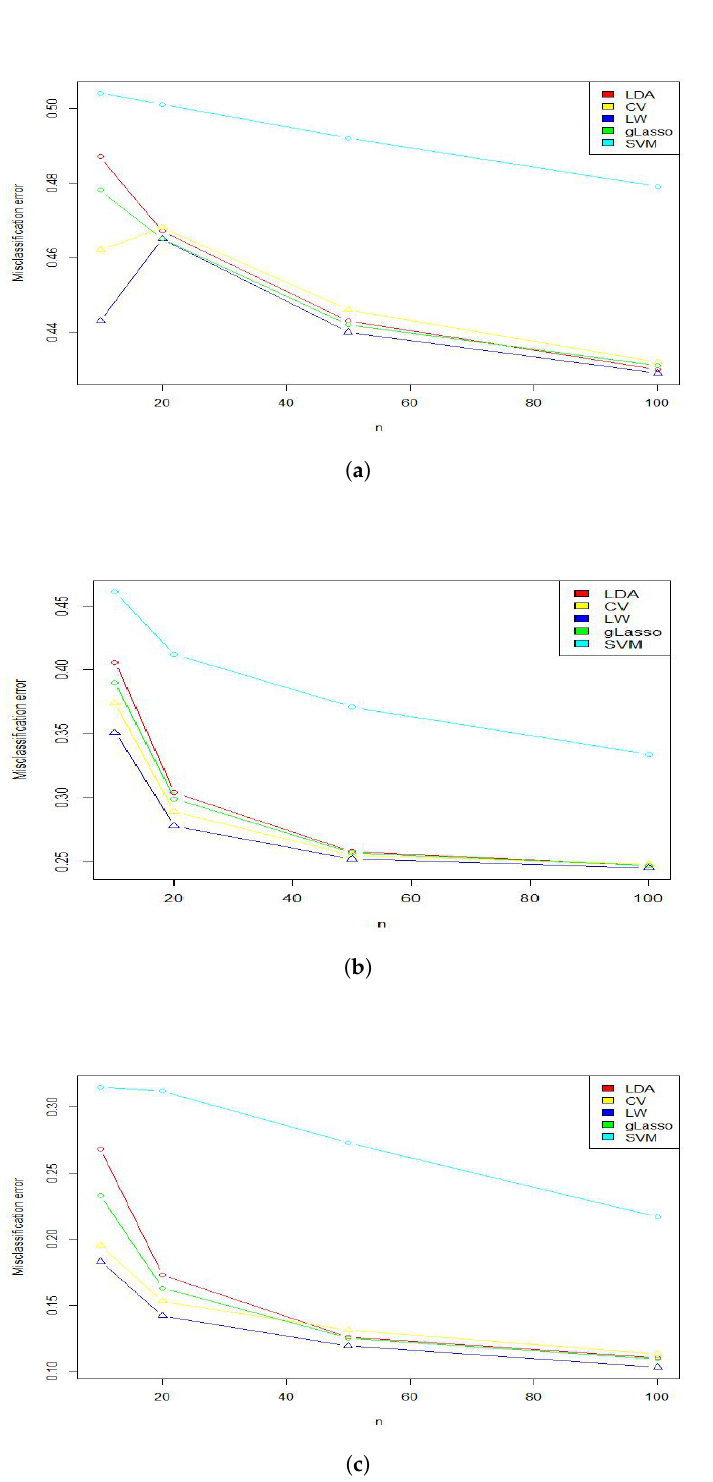
Figure 2. Misclassification error by increasing sample size and p = 12. ( a ) Mod1, ρ = 0.2, D = 0.5; ( b ) Mod1, ρ = 0.2, D = 1.5; ( c ) Mod1, ρ = 0.2, D =